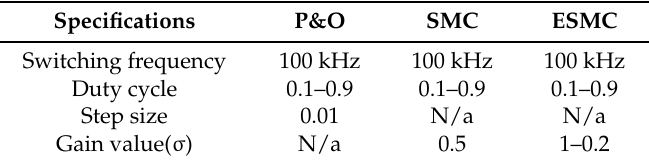
Table 2. Testing results of the proposed control method with different control method. Perturb and observe algorithm: P&O; sliding mode control: SMC; extension SMC: ESMC.